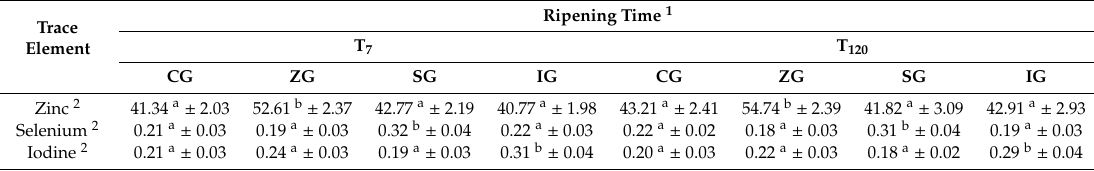
Table 2. Microelements content in cheese samples obtained from lactating dairy cows fed control diet (CG) and control diet supplemented with different trace elements: zinc (ZG), selenium (SG), and iodine (IG).